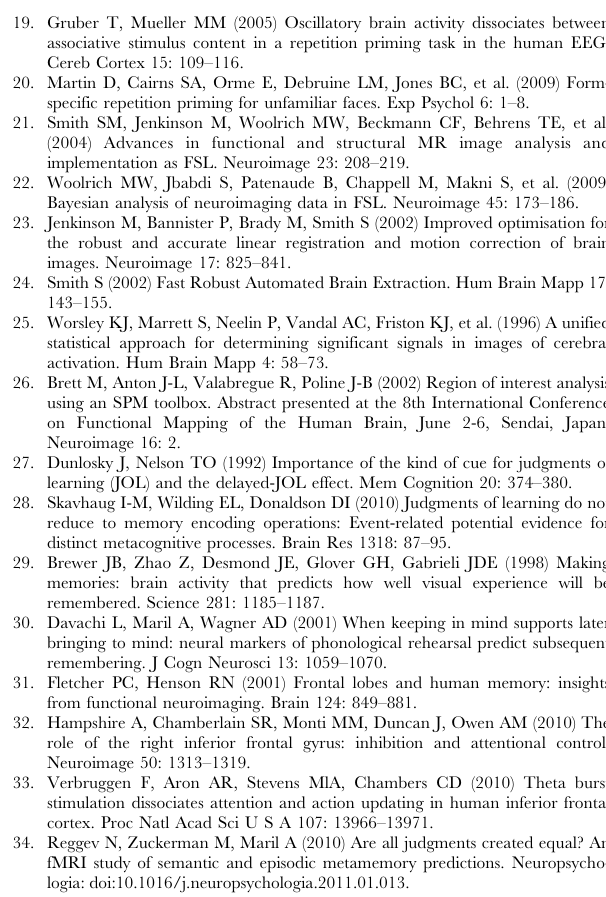
Figure S1 Overview of all additional regions showing increased brain activation during the retrieval phase for hits as opposed to misses (Fig.